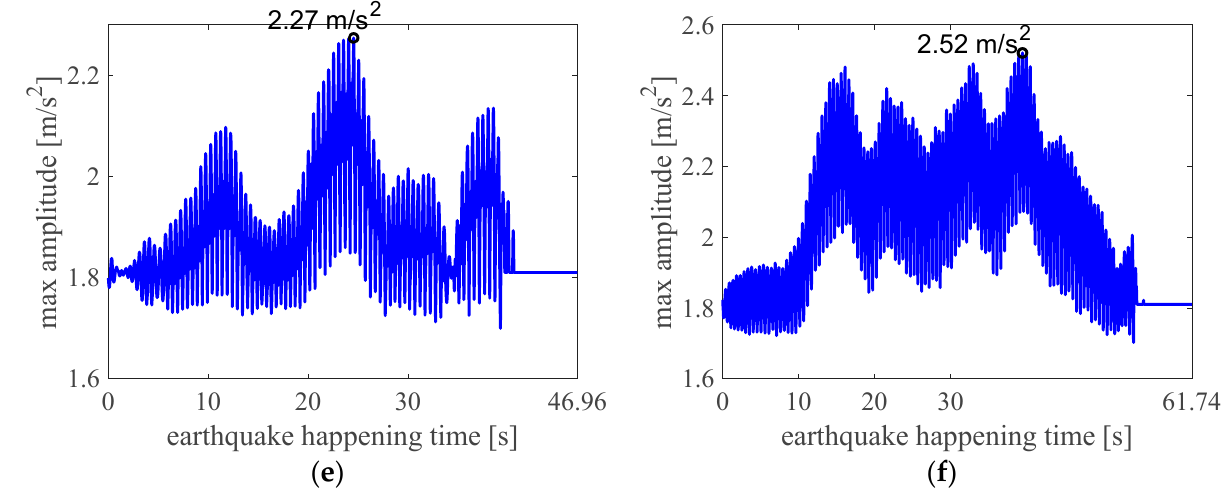
Figure 14. The maximum amplitudes in the time history of the total structural acceleration responses in the vertical (Z) direction to the crowd and the Kobe Earthquake (intensity 7 as an example) that occurs at different time instants 𝑡 (cid:2915)(cid:2927) . ( a ) 0.1 pedestrians/m 2 , ( b ) 0.2 pedestrians/m 2 , ( c ) 0.5 pedestrians/m 2 , ( d ) 0.8 pedestrians/m 2 , ( e ) 1.0 pedestrians/m 2 , ( f ) 1.5 pedestrians/m 2 . Figure 15 presents the empirical cumulative distribution functions (CDFs) based on 7 times of 59 maximum acceleration amplitudes induced by different ground accelerations (1 time) and by both earthquake and crowd loads (6 times). The cases with both the crowd and earthquake loads basically have much higher acceleration amplitudes than the cases with crowd load or earthquake load only. As expected, the lowest and the highest acceleration amplitude curves are obtained by the cases with a low density of 0.1 pedestrians/m 2 and high density of 1.5 pedestrians/m 2 , respectively. However, the amplitudes do not increase with density and there exists a valley for the case with 0.8 pedestrians/m 2 . For the densities in between, the case with a lower density of 0.2 pedestrians/m 2 may induce even higher acceleration amplitudes than the case with 0.8 pedestrians/m 2 .